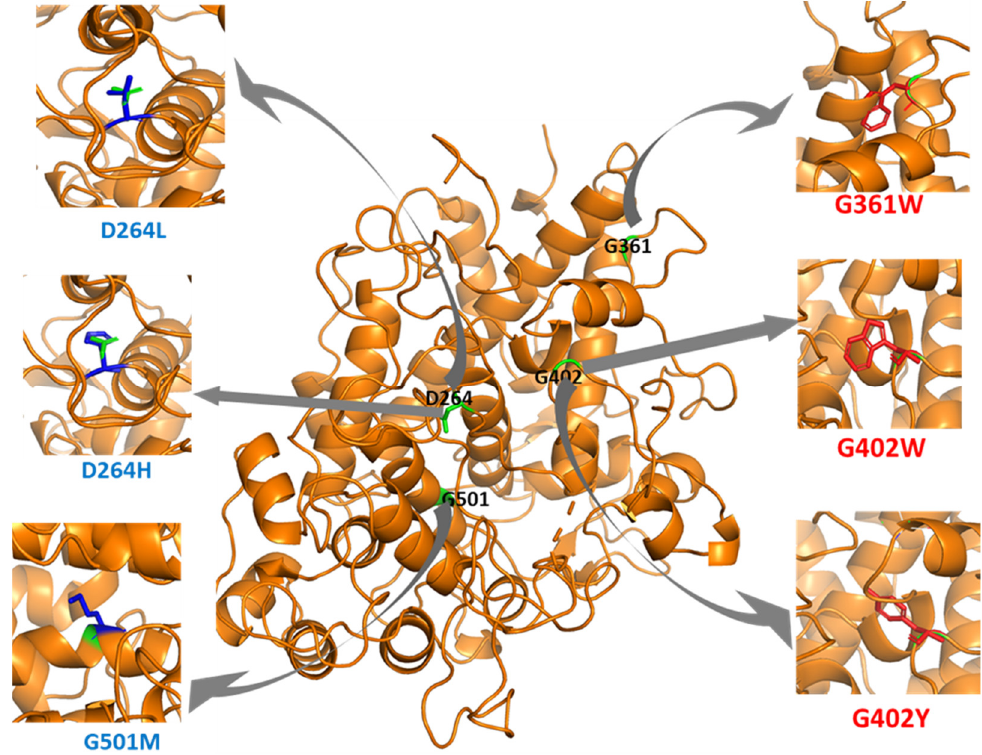
Figure 3. Structural representation of some key missense mutations. Missense mutations in red destabilize the MPO protein ( Right ); Missense mutations in blue stabilize the MPO protein ( Left ); Green represents the wild-type residues.